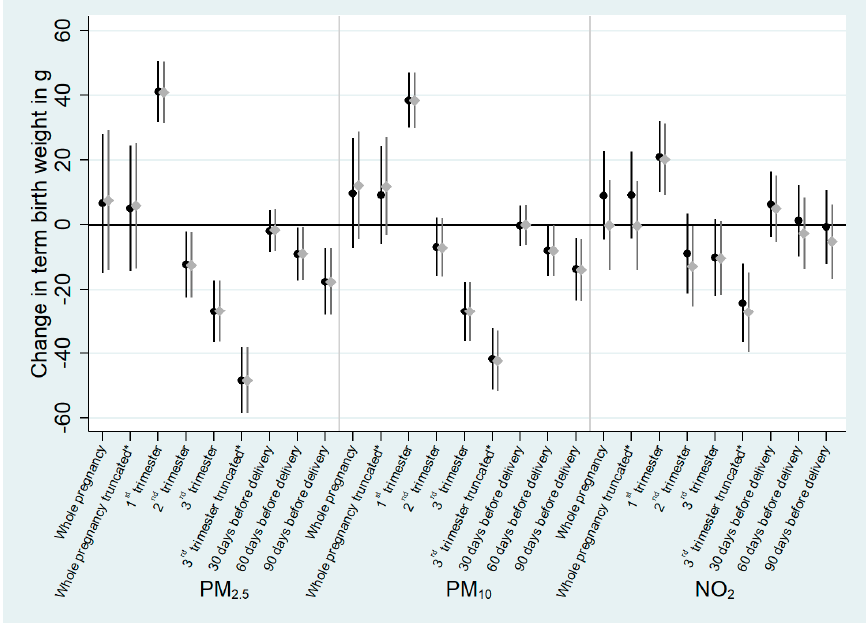
Figure 1. Association between atmospheric pollutant exposure during pregnancy and term birth weight ( n = 13,334 pregnant women from ELFE cohort). All effect estimates correspond to an increase of 5 µ g/m 3 for PM 2.5 and PM 10 and 10 µ g/m 3 for NO 2 . Regression coefficients are from weighted generalized additive models 1 . Full weights are represented in black and trimmed weights in grey. The symbol reflects the central estimate, the line represents the 95% confidence interval. 1 using the stabilized inverse probability of being exposed to air pollutants calculated using maternal education, relationship status, parity, sex of the child, maternal active smoking during pregnancy, social deprivation, maternal French citizenship, maternal age, weight before pregnancy and maternal height, and further adjusted for urbanization level and season of conception. * exposure truncated at 37 gestational weeks.